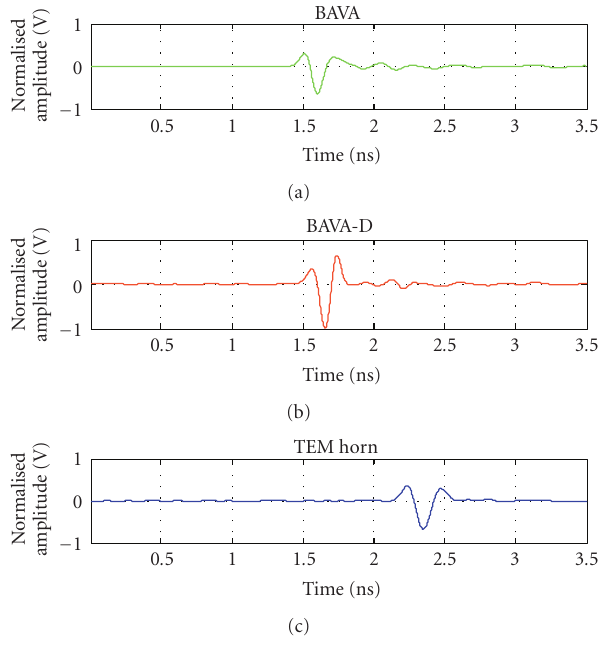
Figure 12: Single signal recorded from breast phantom with anten- nas approximately aligned with tumor. All signals are normalized to the maximum amplitude of the BAVA-D